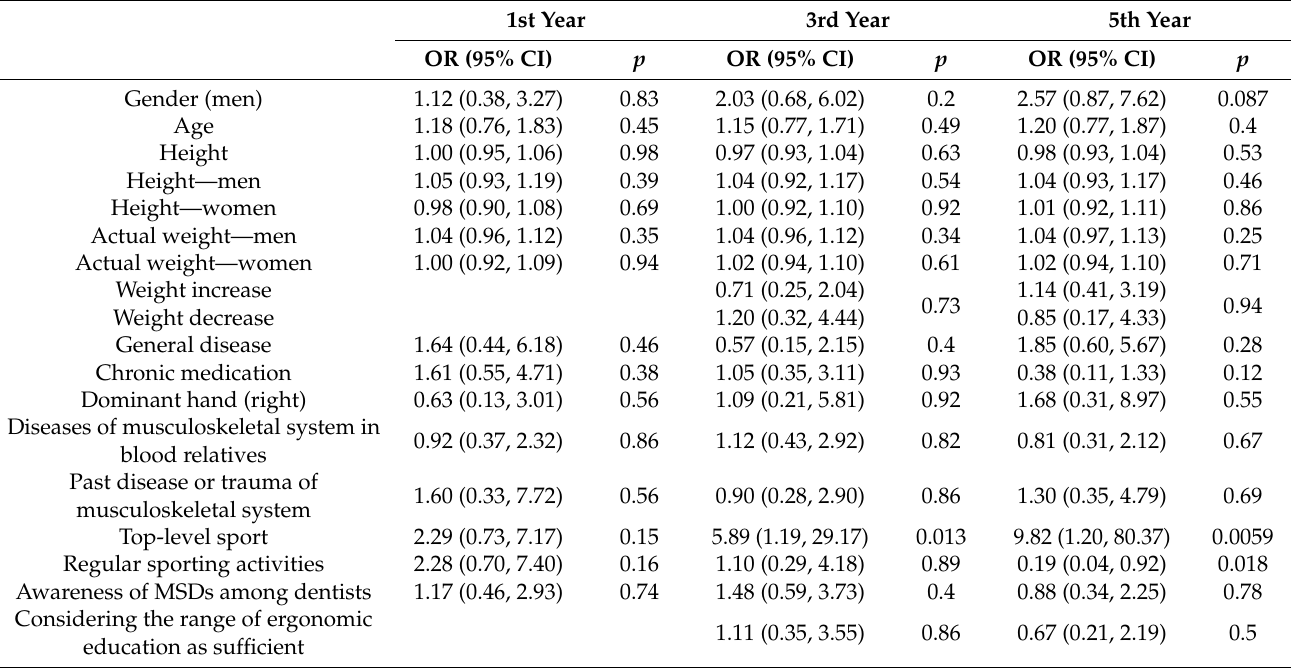
Table 2. The univariate analysis of the influence of the followed factors on the occurrence of neck pain.